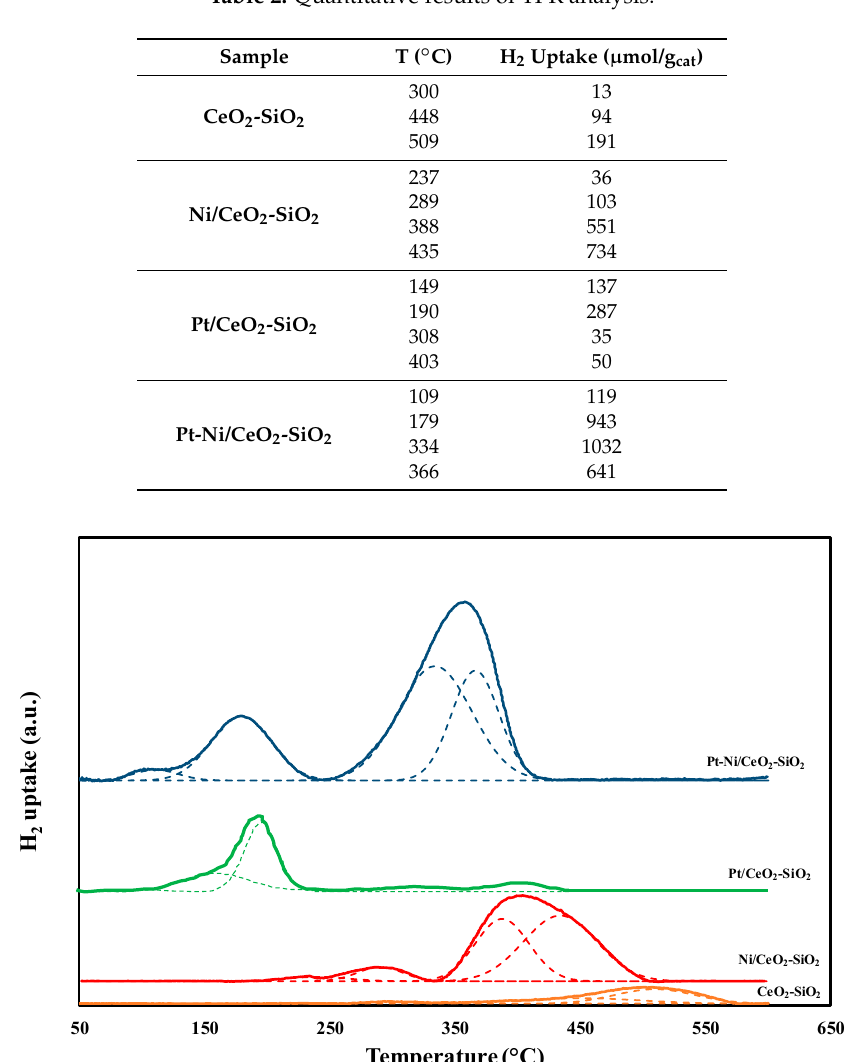
Table 2. Quantitative results of TPR analysis.